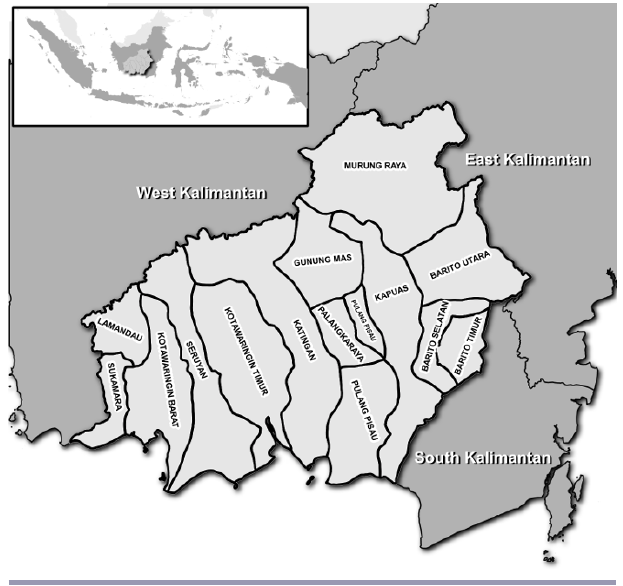
Fig. 1 . Central Kalimantan, Indonesia (Global Administrative Areas